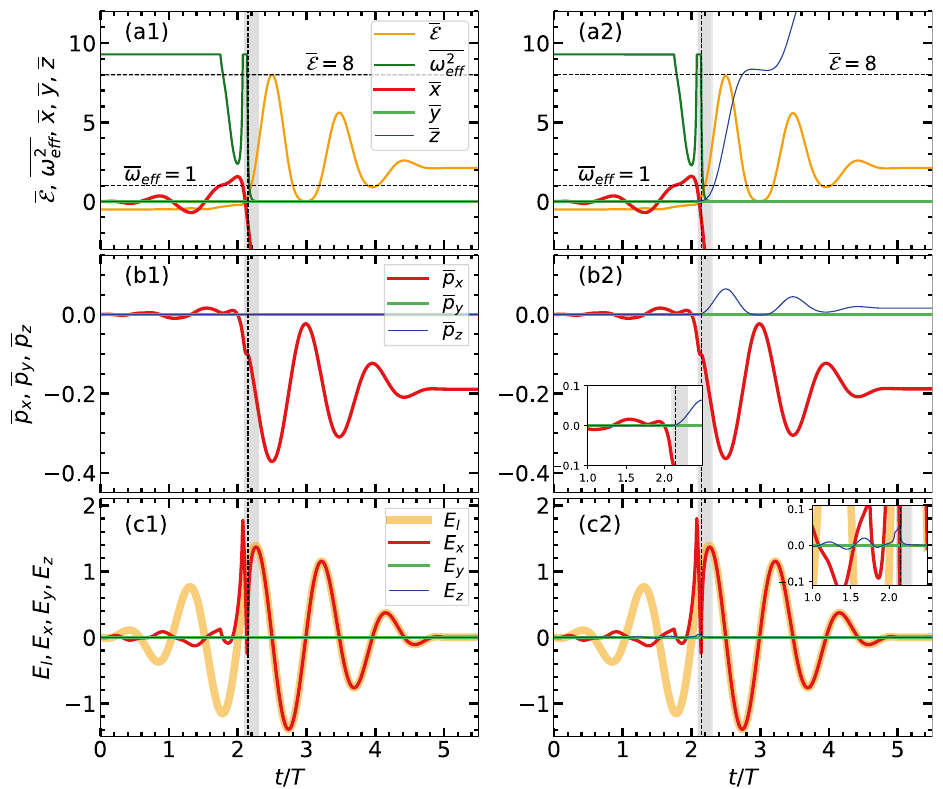
Figure 1. Conventional RSM results without B ext : showing (column-wise) normalized ( x , y , z ), ω 2 eff , E and ( p x , p y , p z ) vs t / T of an initially bound electron 7.13 10 16 W/cm 2 . Associated E x 5 -cycle pulse of I 0 n ≈ × = ˆ x . E E l l vs t / T are also plotted. Panels in the left ( a1,b1,c1 ) and right ( a2,b2,c2 ) columns represent the cases = 0 . The deuterium cluster has number of atoms N 0 and B l with B l = = ω 2 ω 2 /ω 2 9.1 . AHR and outer-ionization occur at t / T r ( 0 ) M eff [ ] = ≈ both cases. B